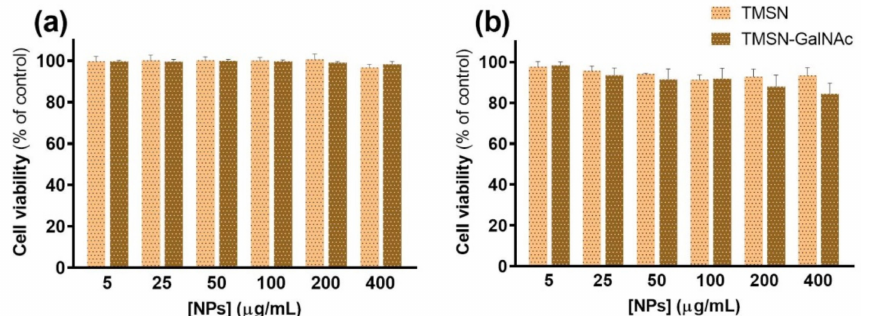
Figure 6. Cell viability of HepG2 cells treated with TMSN and TMSN-GalNAc after 48 h ( a ) and 72 h ( b ) of incubation. Data are presented as a percentage of untreated control cells (mean ± SD), obtained from triplicates, and are representative of at least three independent